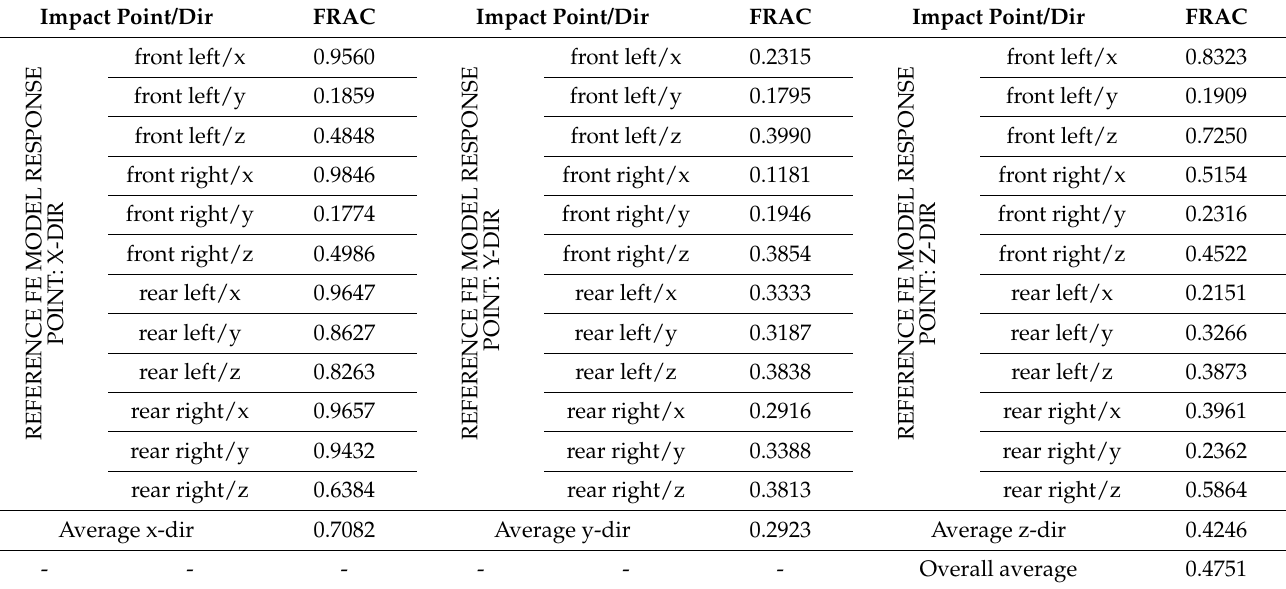
Table 6. FRAC results for the adjusted FE model of the vehicle body